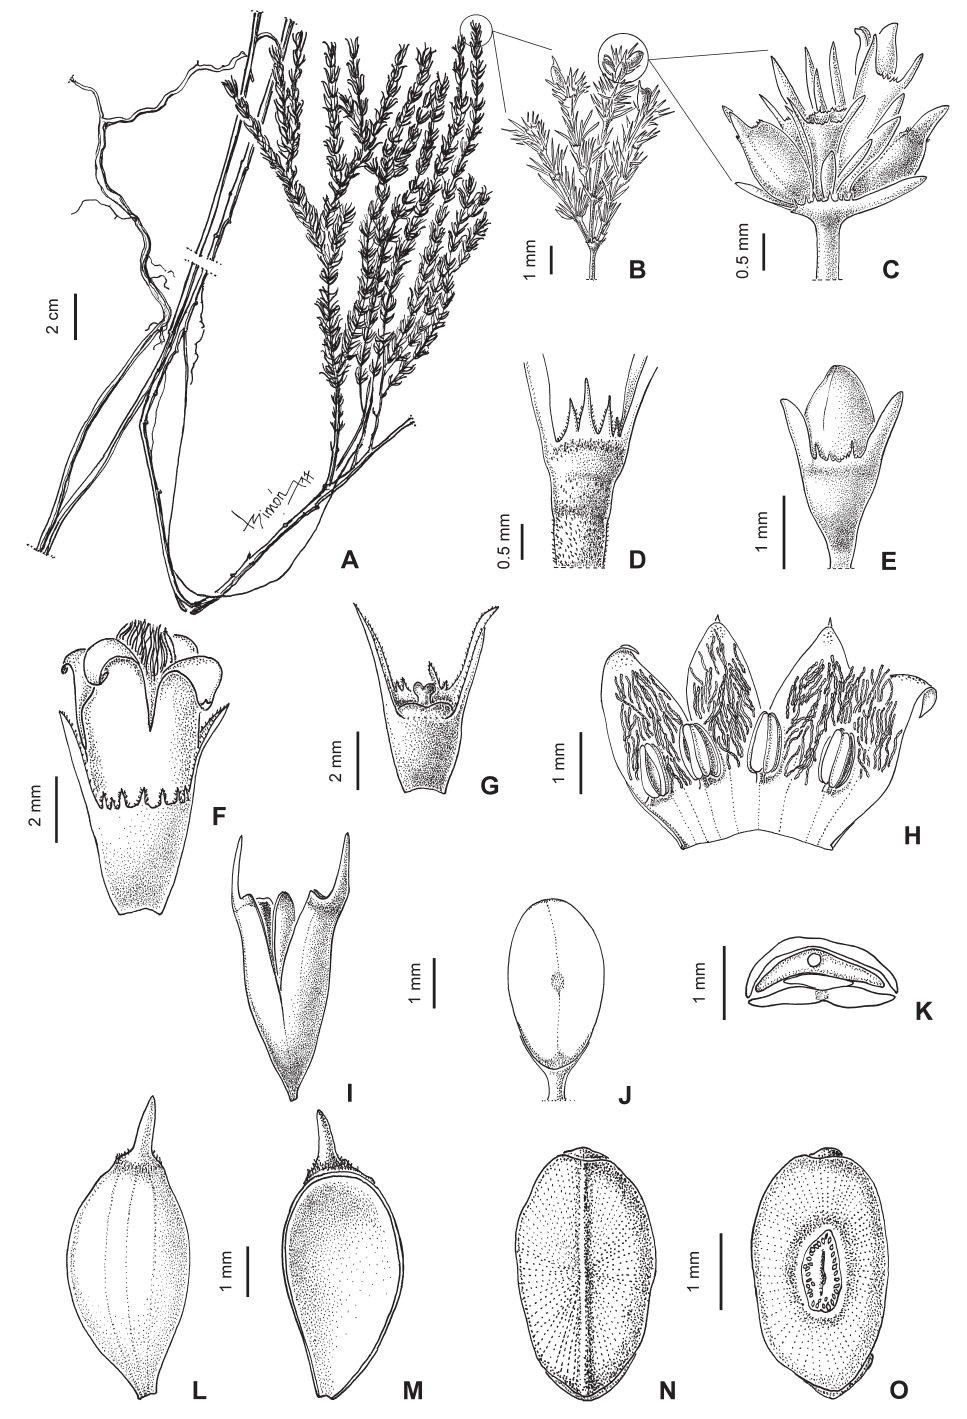
Fig. 2. Psyllocarpus vianae Sobrado, J.A.M.Carmo & R.M.Salas sp. nov.; P.L. Viana et al. 5887